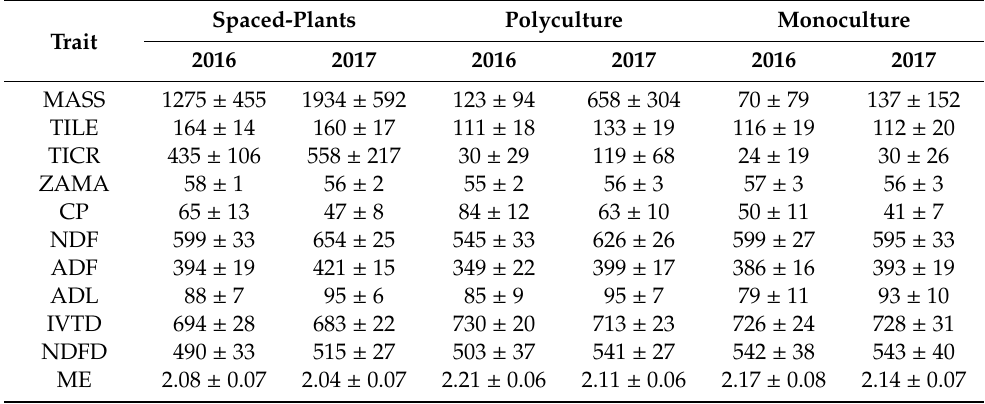
Table A1. Trait means ± SD by year for 192 full-sib progeny genets of the M26 × M35 intermediate wheatgrass mapping population evaluated over two years 2016–2017 at Logan, UT, USA in three clonally replicated competition